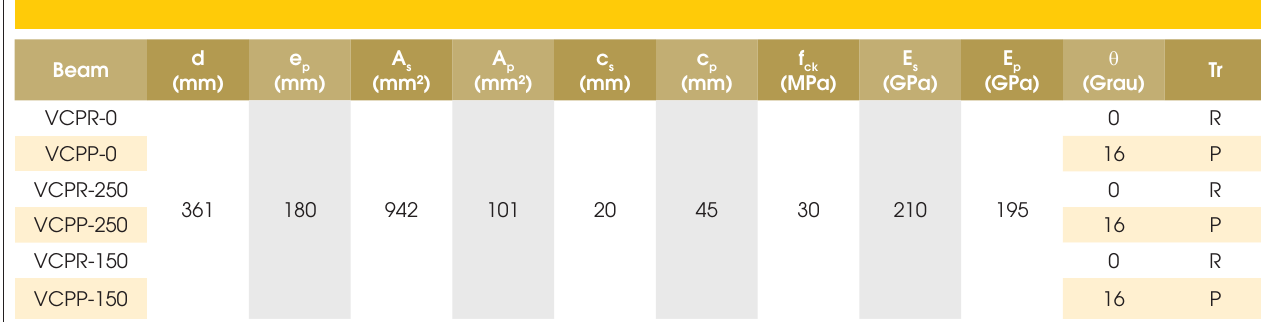
Table 3 – Current Beam’s characteristics